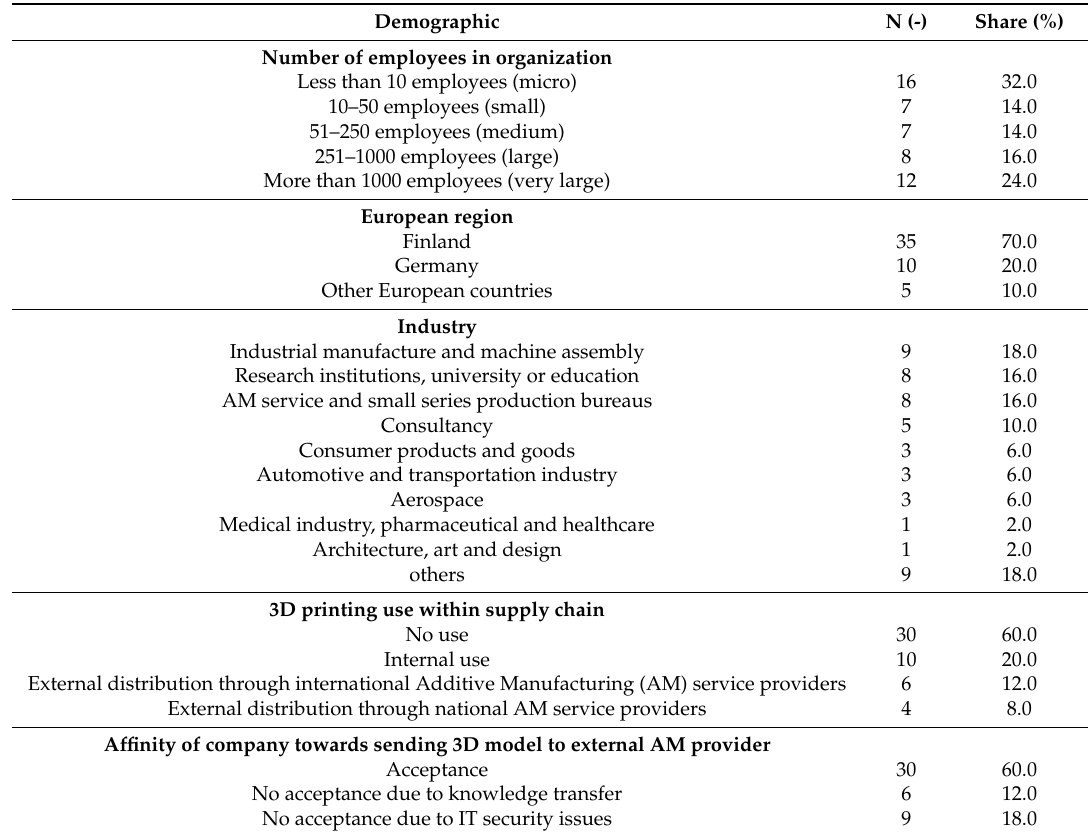
Table 1. Demographics of survey